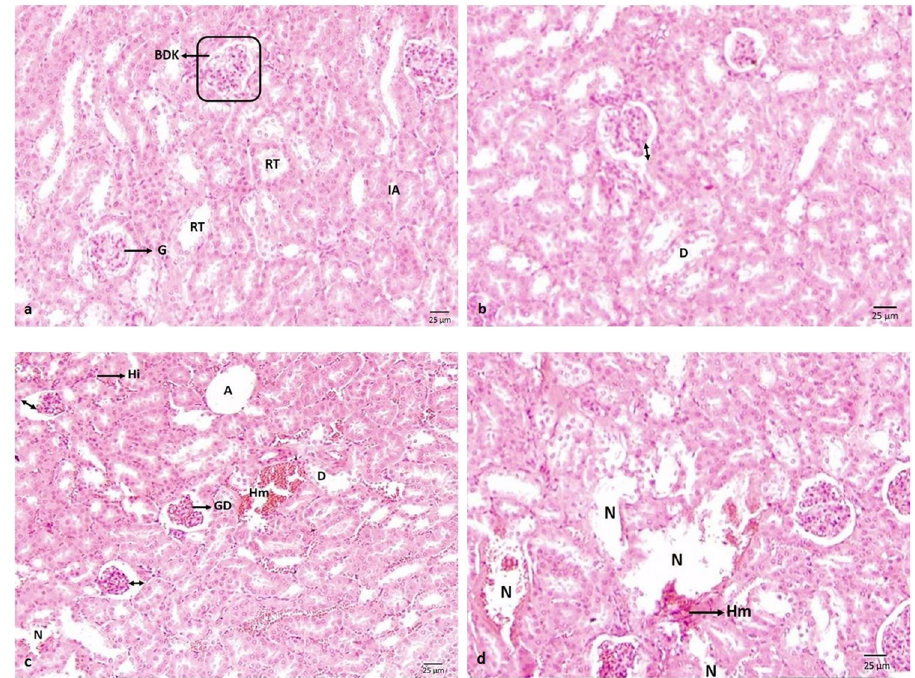
Figure 1: ( a ) Kidney histology of negative control group; ( b ) histological structure of the kidney in the 5 mg kg − 1 acetamiprid group; ( c ) histological structure of the kidney in the 10 mg kg − 1 acetamiprid group; and ( d ) histological structure of the kidney in the 15 mg kg − 1 acetamiprid group, RT, IA, glomerulus ( G ) , malpighian corpuscle ( rounded rectangle ) , CTC, degeneration ( D ) , increase in capsular area ( bowman ) ( ↔ ) , GD, hyperchromasia ( Hi ) , haemorrhage ( Hm ) , atrophy ( A ) , necrosis ( N ) , and Bar: 25 µm, H&E.